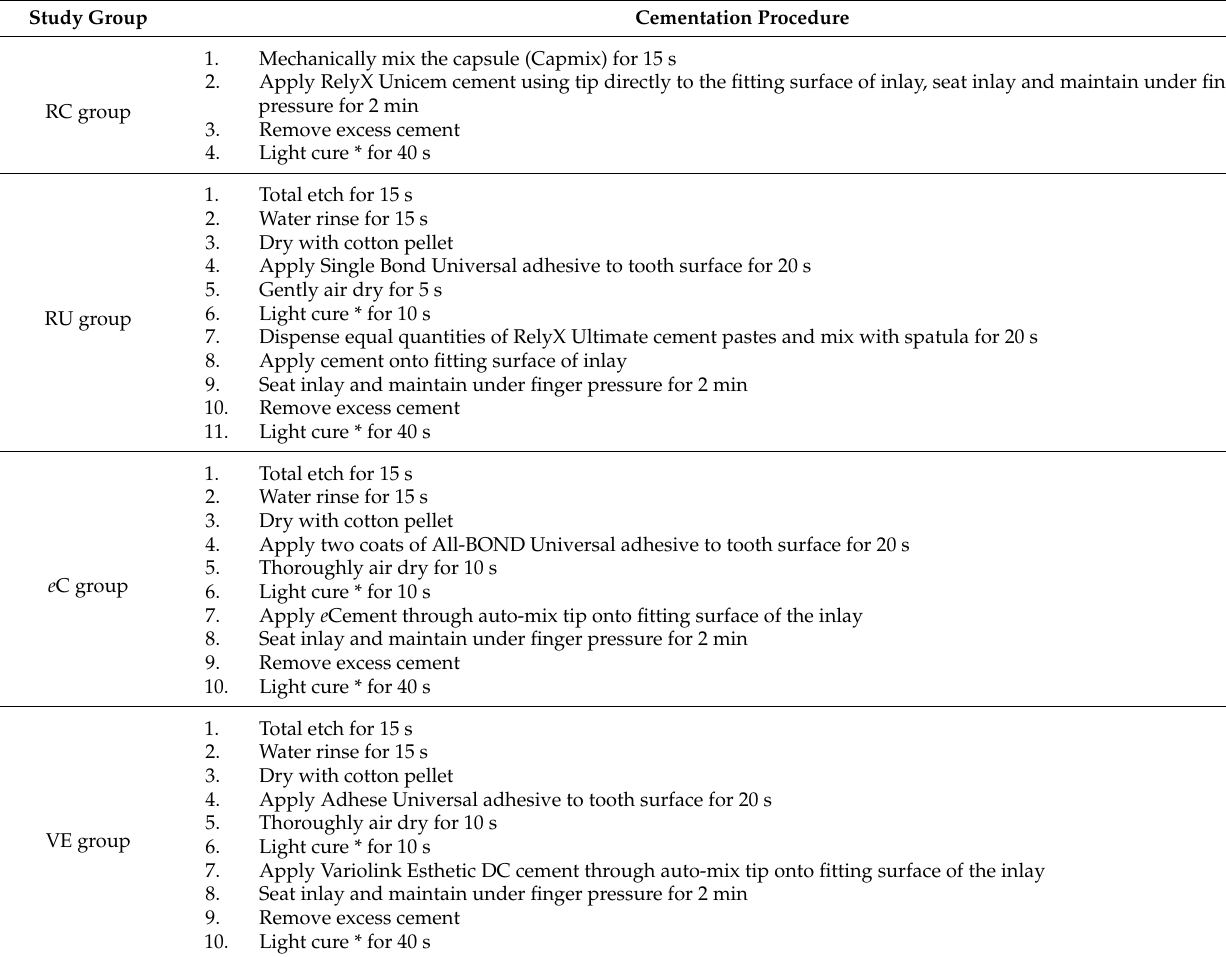
Table 2. Cementation